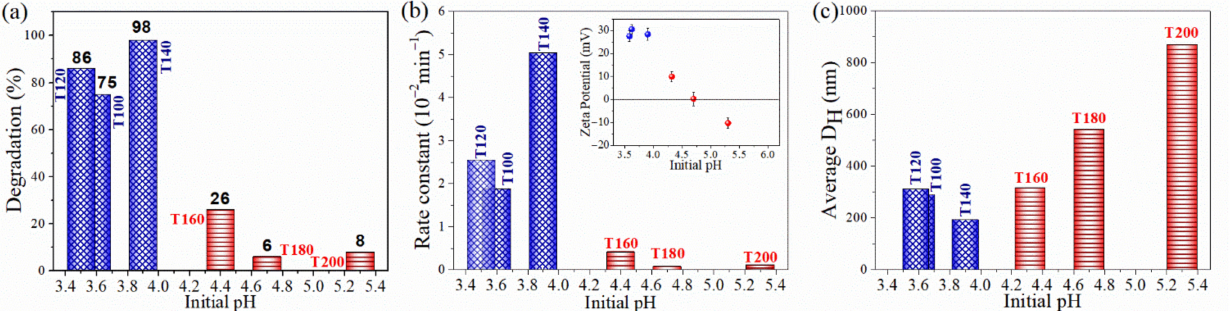
Figure 10. ( a ) Distribution of the degradation percentage in terms of the initial pH, ( b ) rate constant against the initial pH (the inset: ζ -potential as a function of the initial pH), and ( c ) the average D H plotted against the initial pH of the TiO 2